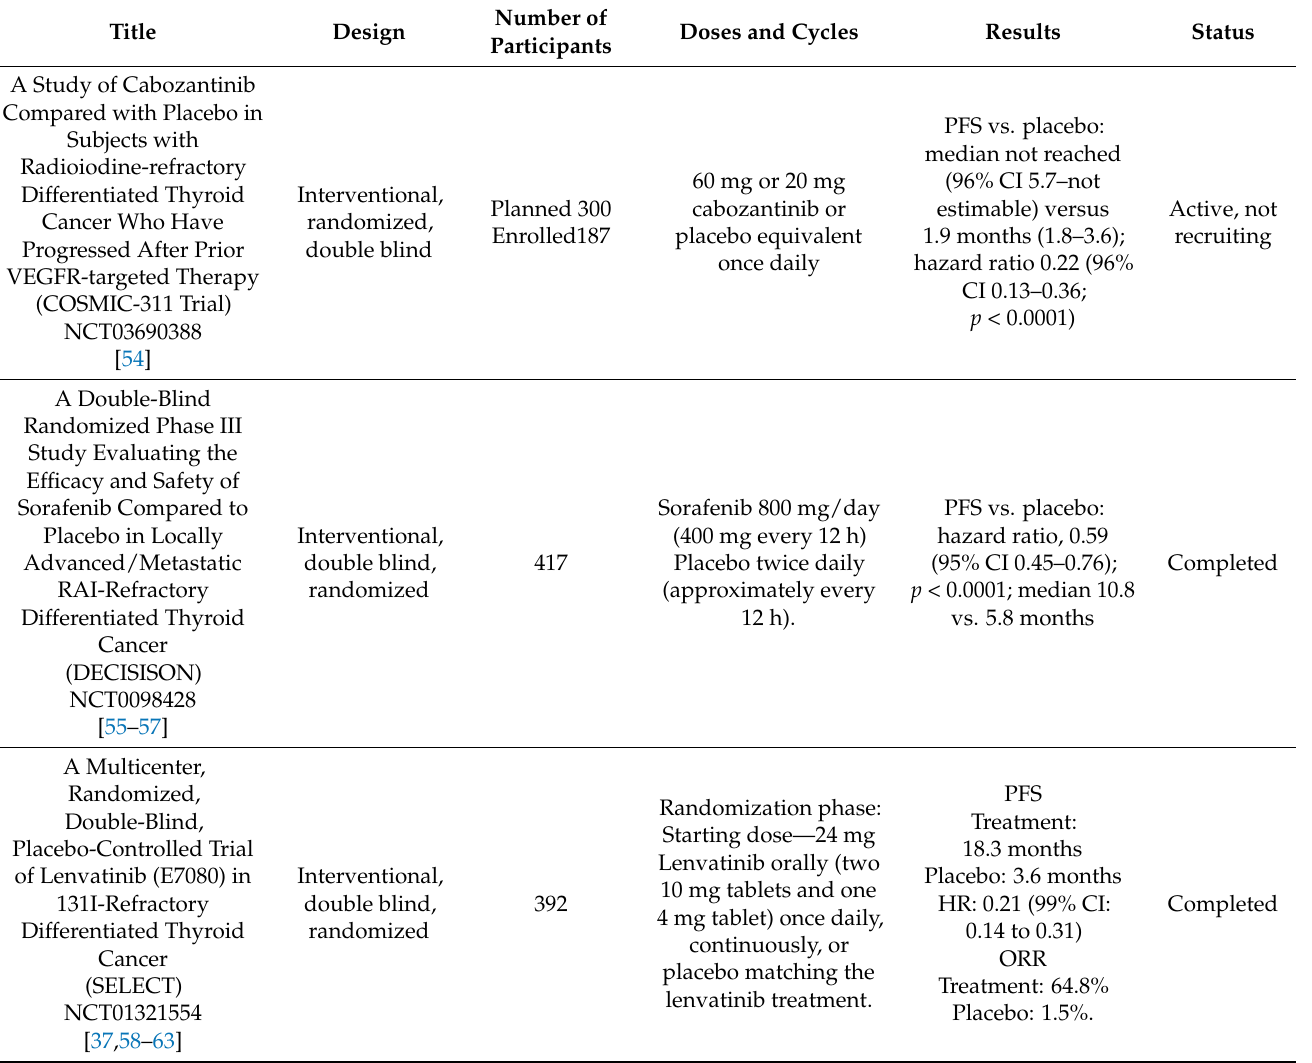
Table 2. Overview of the three pivotal phase 3 trials for cabozantinib, sorafenib, and